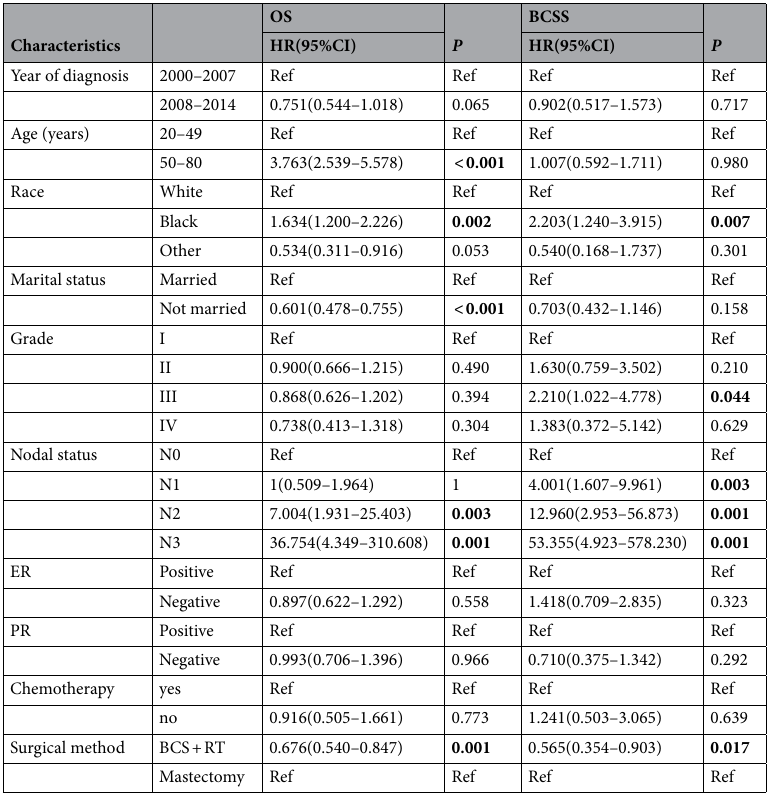
Table 3. Prognostic factors for OS and BCSS in multivariate analysis after PSM. OS overall survival; BCSS breast cancer-specific survival; PSM propensity score matching. Significant values are in